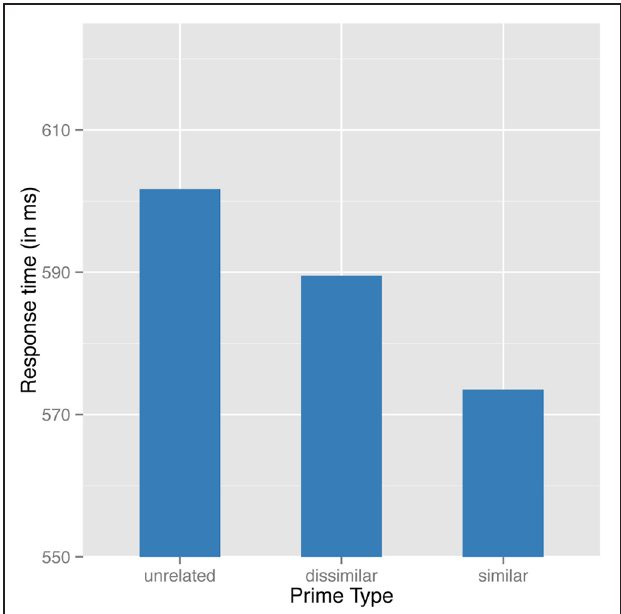
FIGURE 7 | Predicted values for the partial effect of type of prime on decision latencies at a 34 ms SOA.